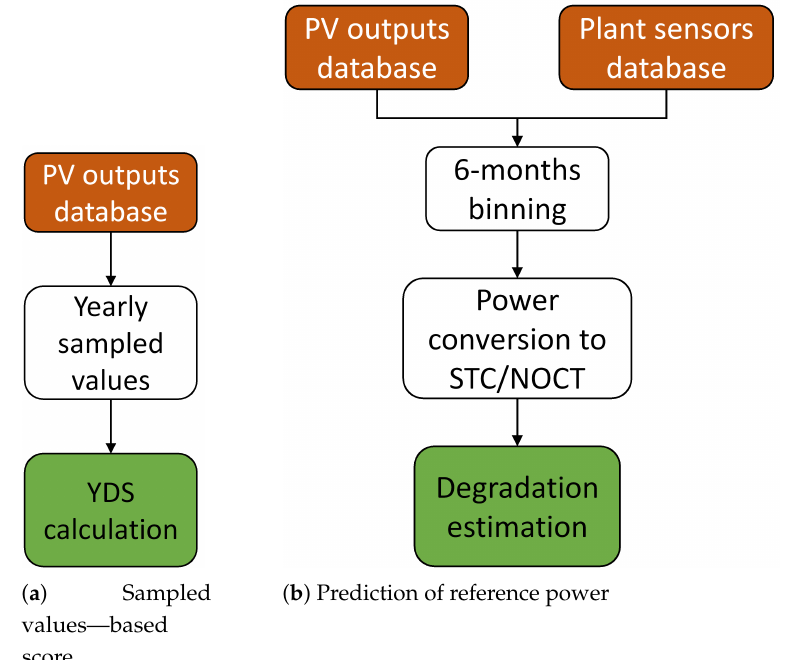
Figure 1. Flowcharts describing the two approaches for degradation